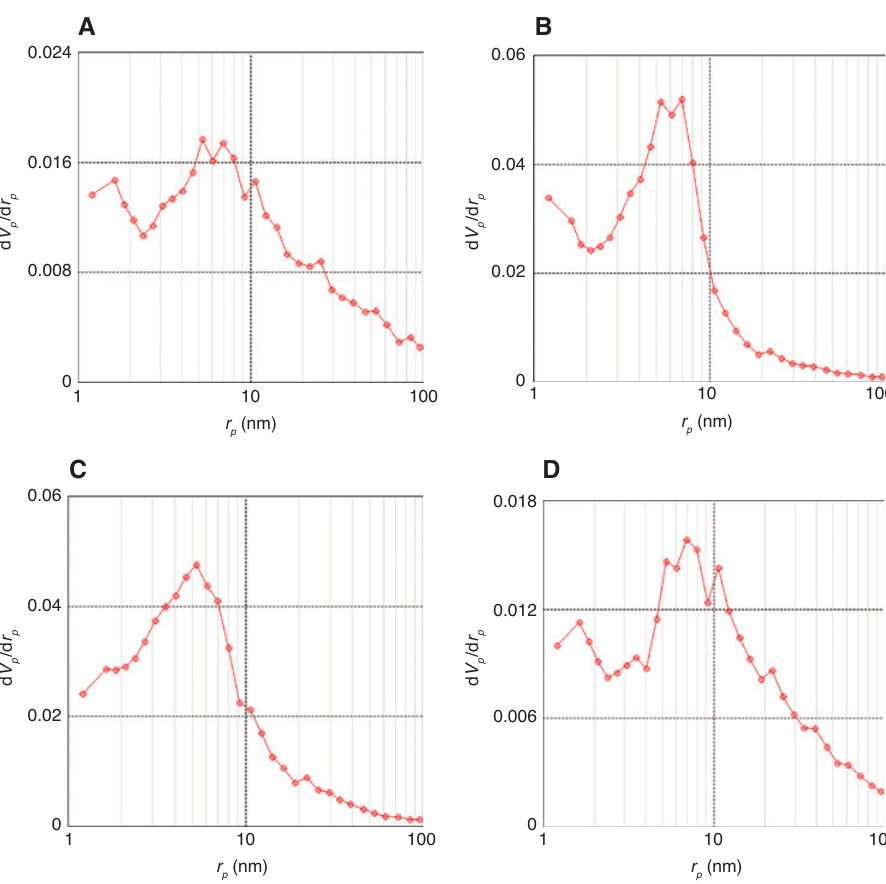
Figure 6: Pore size distribution of materials B: (A) re-MgO-0, (B) re-MgO-1, (C) re-MgO-2, (D)